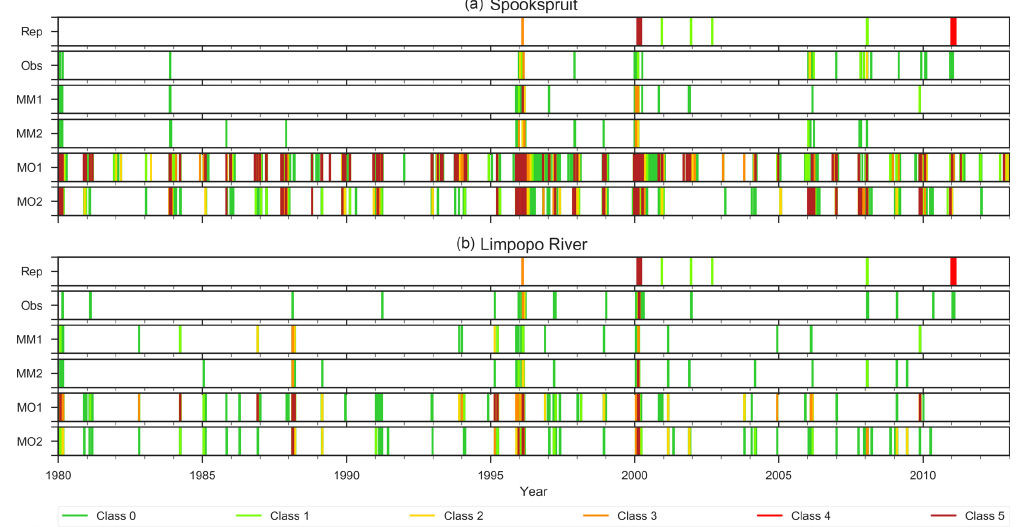
Figure 3. Occurrence of flood events of increasing severity classes at the Spookspruit gauge (252km 2 ; a ) and in the main Limpopo River (98240km 2 ; b ). Model flood events were identified using model climatology (MM1 and MM2) or observed climatology (MO1 and MO2) and were compared to benchmarks based on a compiled disaster impact database (Rep) and observed river discharge data (Obs). The index value refers to models with 0.5 ◦ resolution (MM1 and MO1) and 0.25 ◦ resolution (MM2 and MO2). Results are shown for the WaterGAP3 model, which is available in the eartH2Observe Water Resources Reanalysis